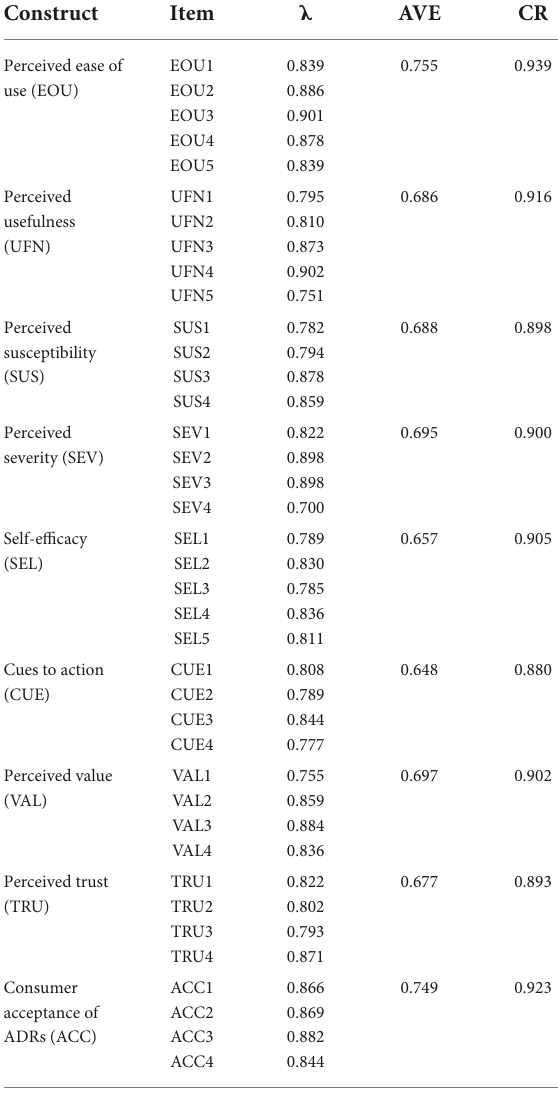
TABLE 4 Results of